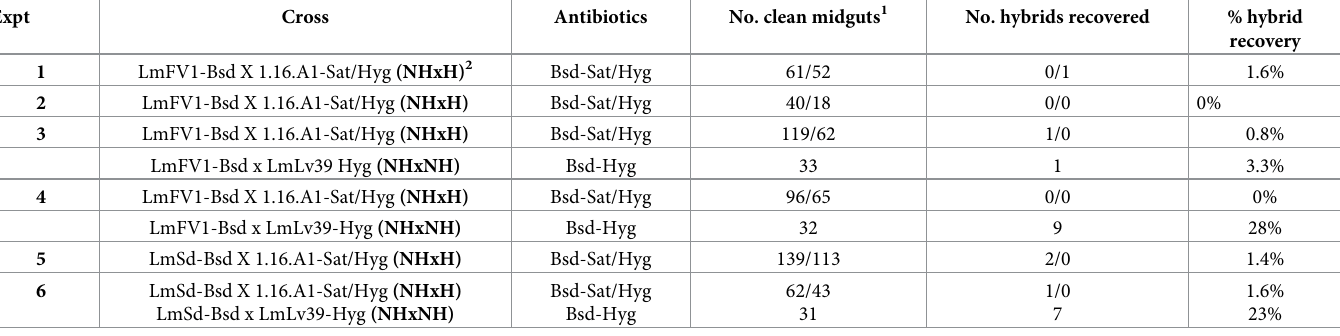
Table 2. Backcross/outcross matings in P . duboscqi involving an L . major intraspecies F1 hybrid. Expt